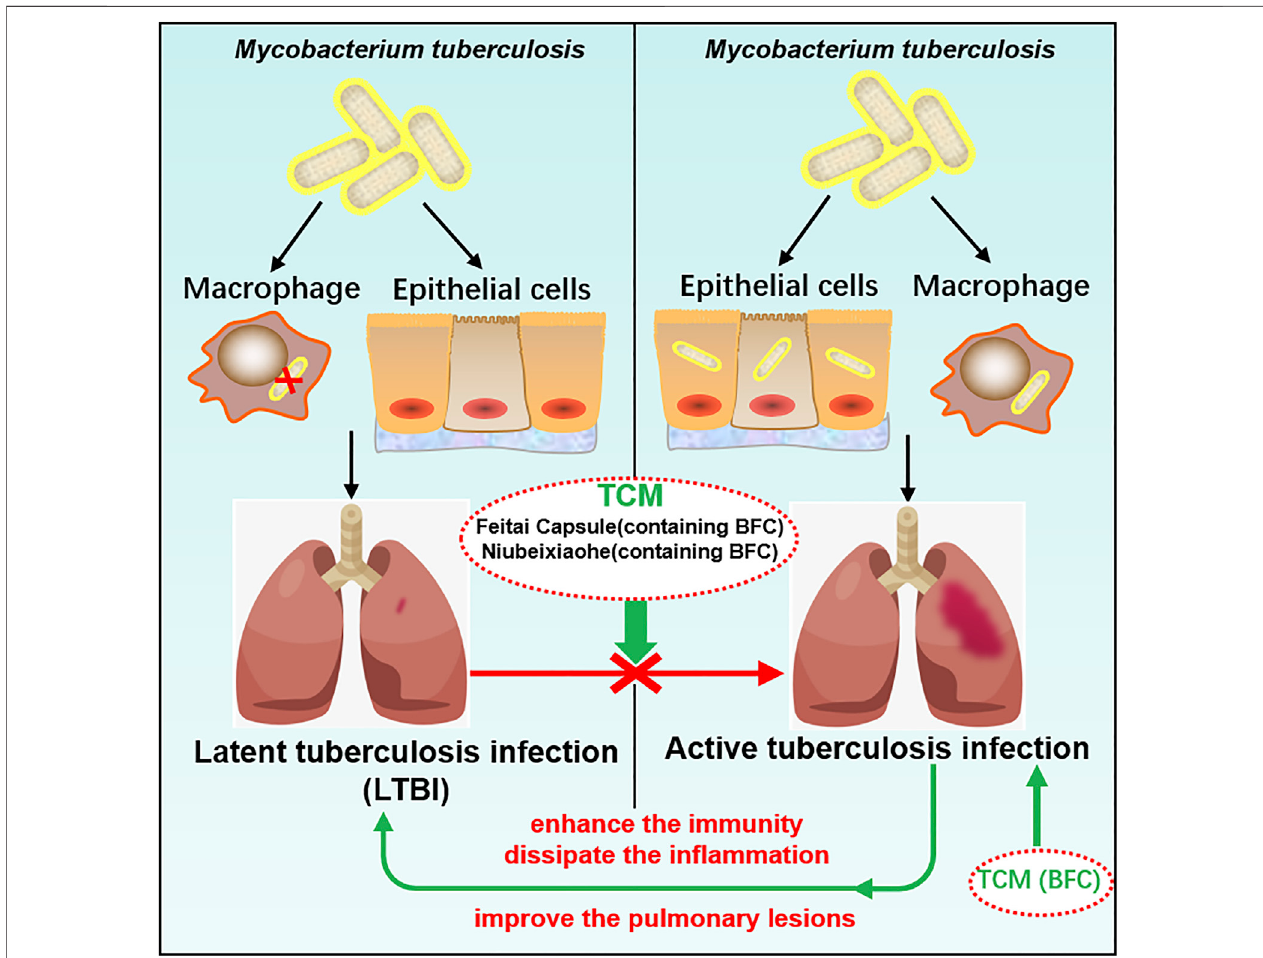
FIGURE 7 | The mechanism of BFC in the treatment of pulmonary